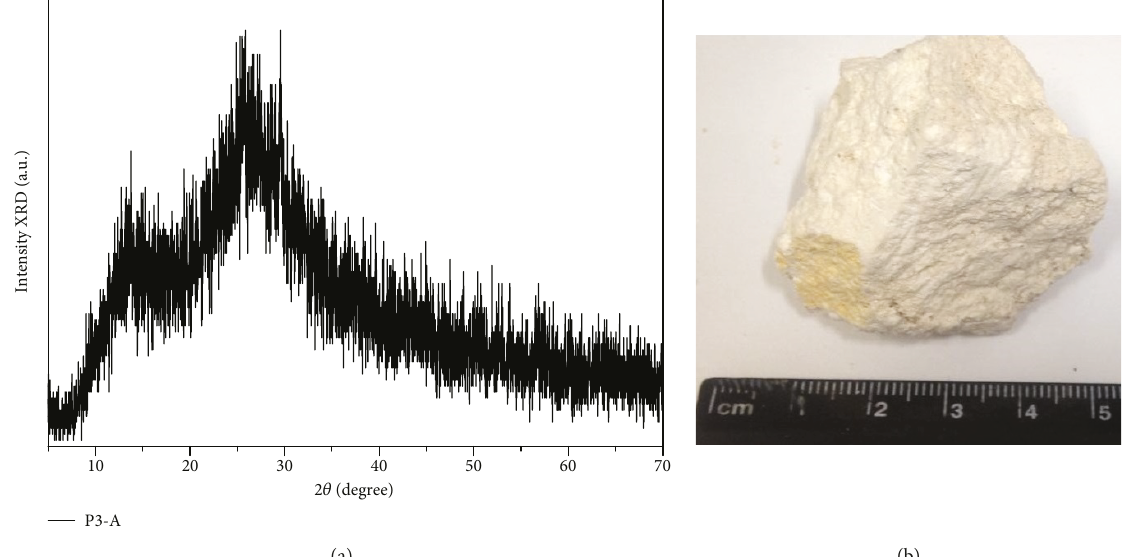
Figure 13: Sample P3-A (a) XRD patterns and (b) sample of breccia.